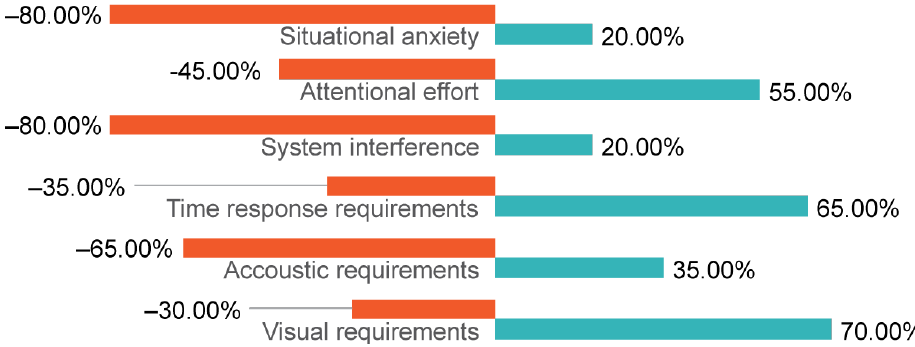
Figure 19. Subjective workload perceived by the users.